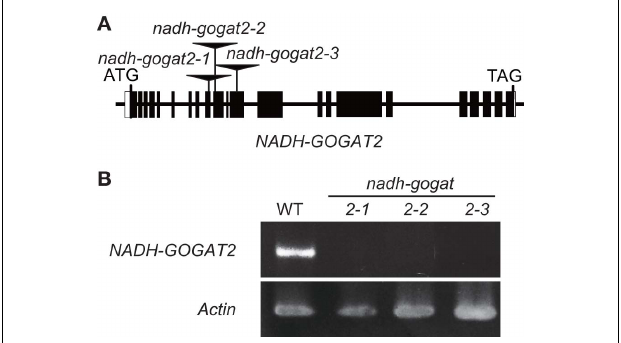
FIGURE 1 | Isolation of OsNADH-GOGAT 2 knockout mutants of rice. (A) Diagram of the insertion position of retrotransposon Tos 17 in OsNADH-GOGAT 2 . Exons are indicated as boxed regions whereas lines represent introns and the 5 (cid:2) - and 3 (cid:2) -untranscribed region.The open box corresponds to untranslated sequences. (B) Confirmation of no expression of mRNA for OsNADH-GOGAT 2 in three knockout lines with RT-PCR.The seedling of wild-type (WT) and Tos 17-inserted homozygous lines were grown on a synthetic cultured soil in green house for 22days, and its third leaf blade was harvested for RT-PCR